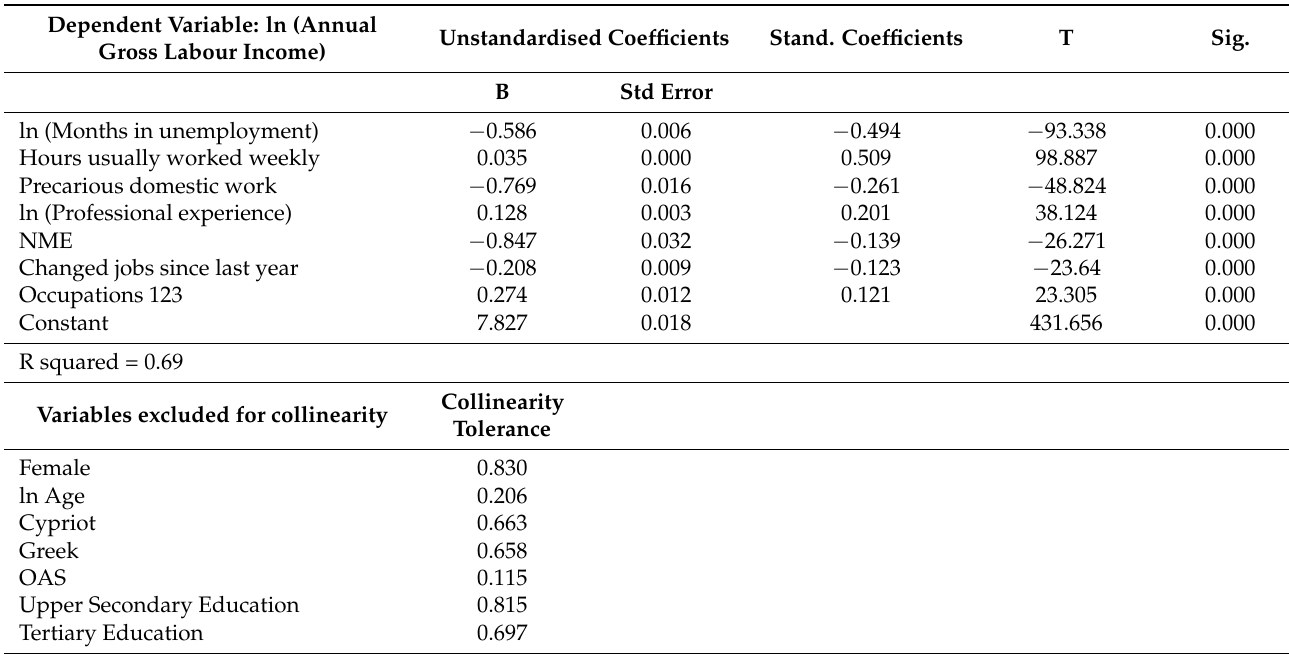
Table 3. Results of the regression: factors affecting labour income of the precarious.